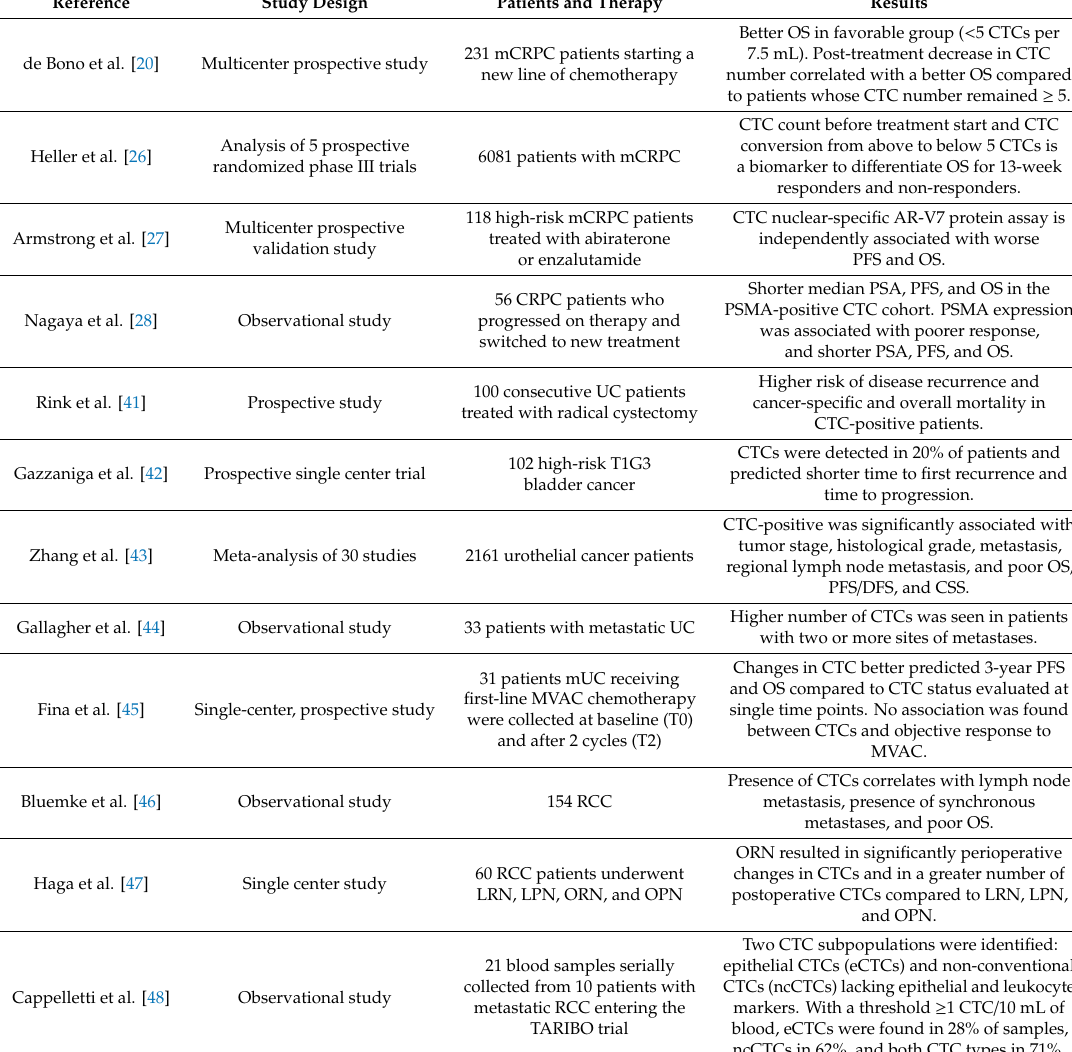
Table 1. Selected studies on CTCs in prostate cancer, urothelial carcinoma, and renal cell